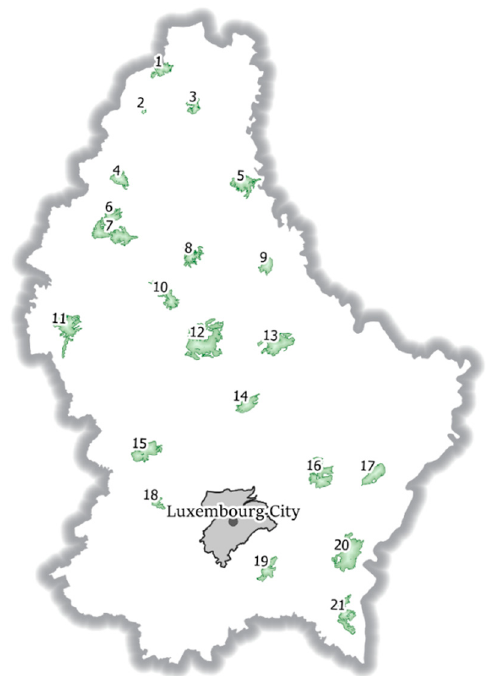
Figure 3. Selected OpenStreetMap (OSM) mixed forest polygons and their location in the Grand Duchy of Luxembourg.